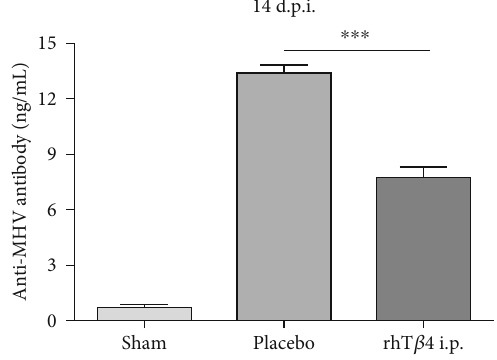
Figure 3: Anti-MHV antibody concentrations in serum at 14 d.p.i. The MHV antibodies in mice serum of group sham ( n = 13 ), placebo ( n = 2 ), AND rhT β 4 ( n = 11 ) were quanti fi ed by ELISA. The unpaired t - test was used to compare two group data. ∗∗∗ P < 0 : 001